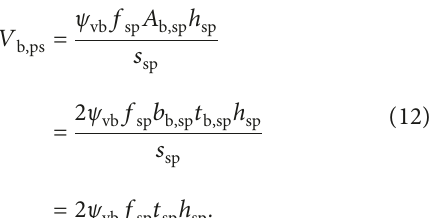
vb . Adding anchor Rubber anchor or steel seal hoop anchor U-hoop